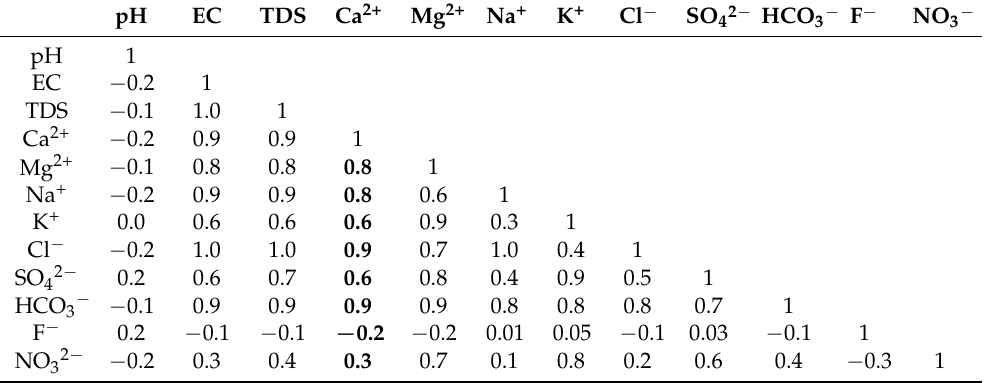
Table 2. Correlation coefficients of major physiochemical parameters in the Soutpansberg region.